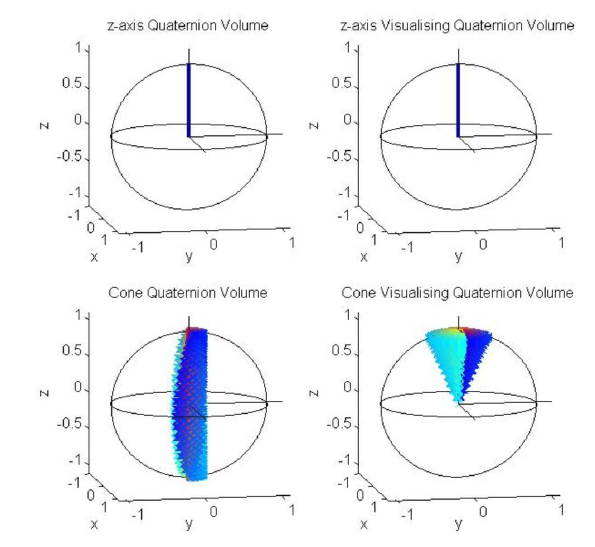
Figure 1: The quaternion volume and the visualising quaternion volume in the xyz -sphere. The upper plots show a freedom about the z - axis and the lower plots show all directions that span out a cone and the orientations about these direction vectors. The visualis- ing quaternion volume gives a more intuitive picture of the orientations described by the quaternion